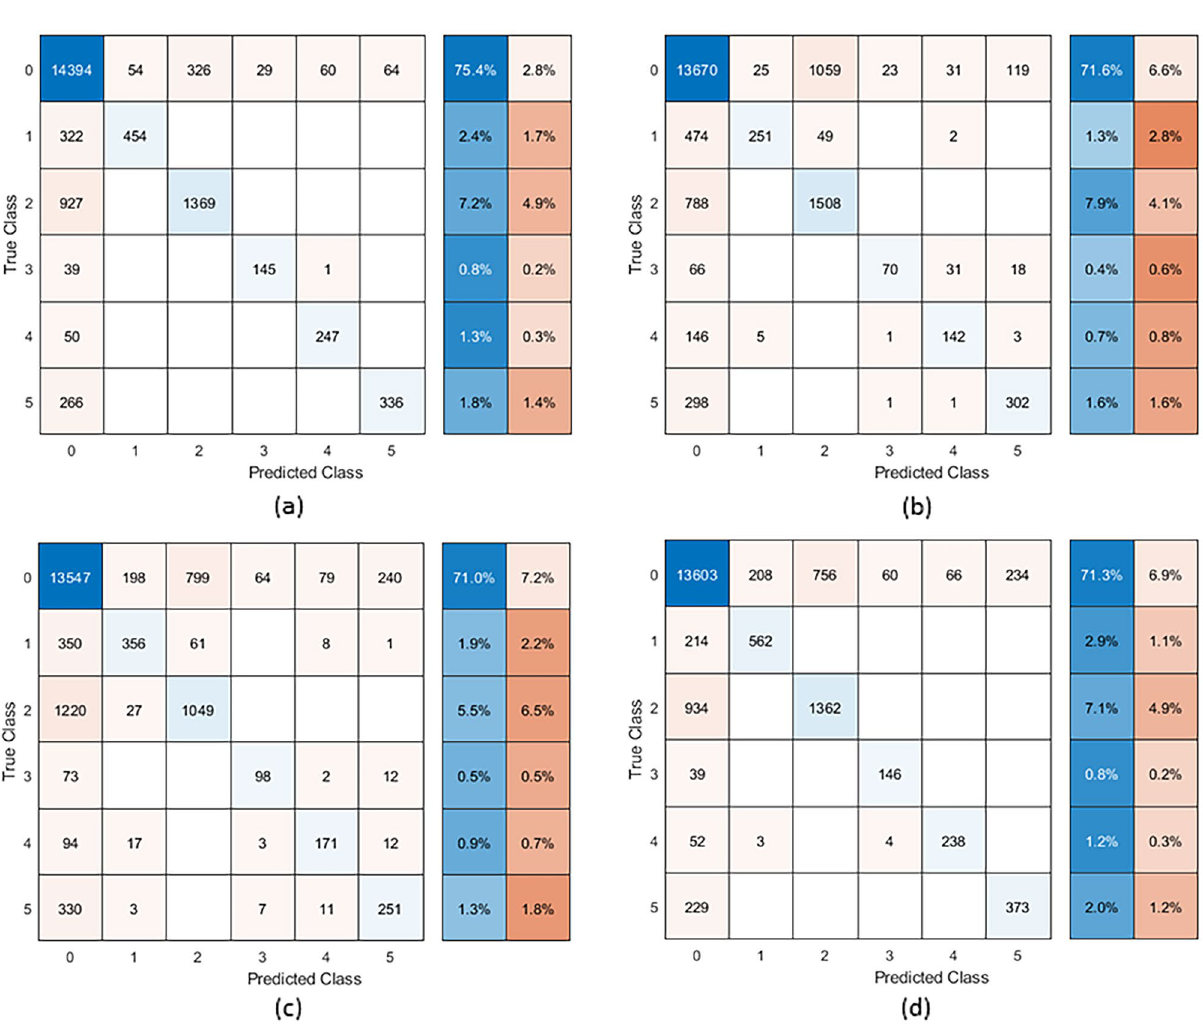
Figure 4. Confusion matrix of classifiers on chronic back pain and pain-free classes with ( a ) Support Vector Machine, ( b ) Naïve Bayes, ( c ) k-Nearest Neighbour and ( d ) Random Forest classifiers. The x-axis is the predicted class while the y-axis is the true class. Blue squares indicate the number in the class that was accurately classified, while the oranges squares show the number of misclassifications. The boxes on the right of the matrix show the percentage of classification (blue) and misclassification (orange) for the class. Classes are (0) pain-free individuals (n = 14,927; 78.2%), (1) low social isolation/loneliness and moderate depressive symptoms (n = 776; 4.1%), (2) low loneliness/social isolation and depressive symptoms (n = 2296; 12.0%), (3) high loneliness/social isolation and moderate depressive symptoms (n = 185; 1.0%), (4) moderate loneliness/social isolation and high depressive symptoms (n = 297; 1.6%) and (5) moderate loneliness/social isolation and low depressive symptoms (n = 602;